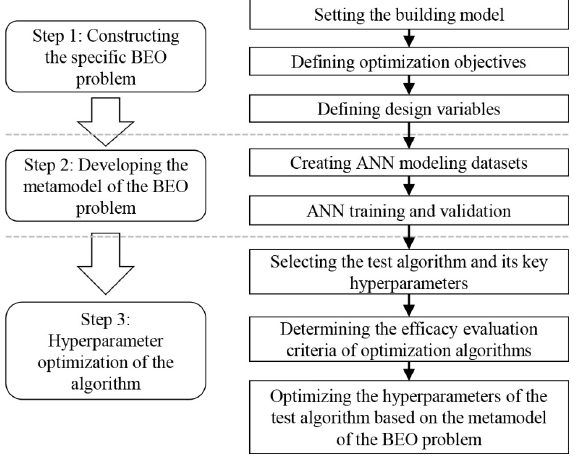
Figure 3. Flowchart of the methodology.